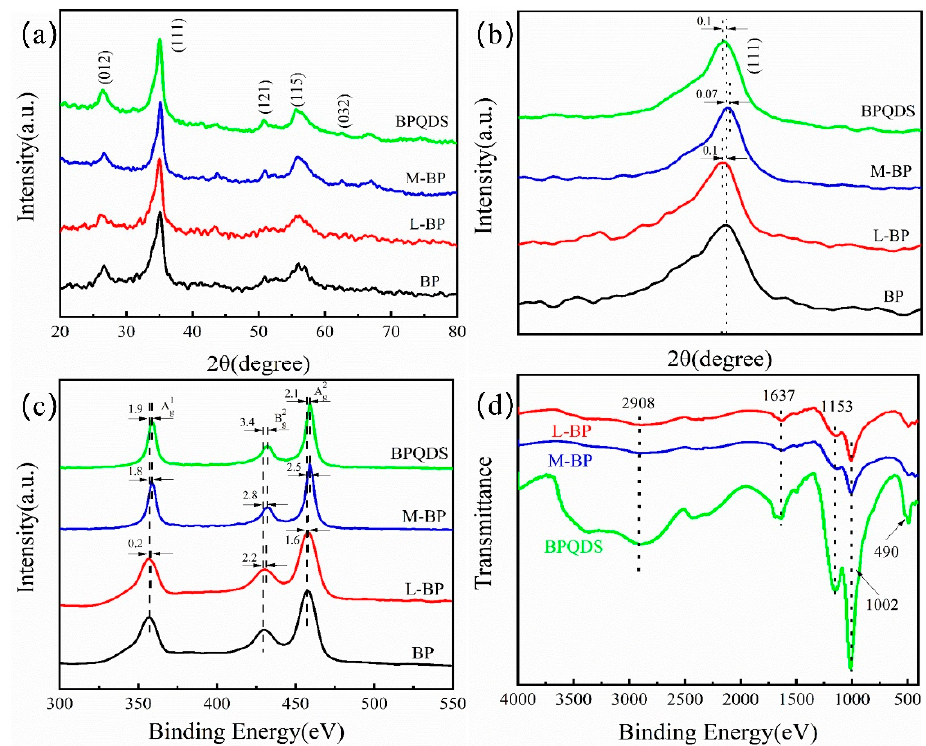
Figure 3. ( a ) XRD patterns, ( b ) the partial magnification of the (111) peak, ( c ) Raman spectrum, and ( d ) FTIR spectra of different-sized BP-NS.